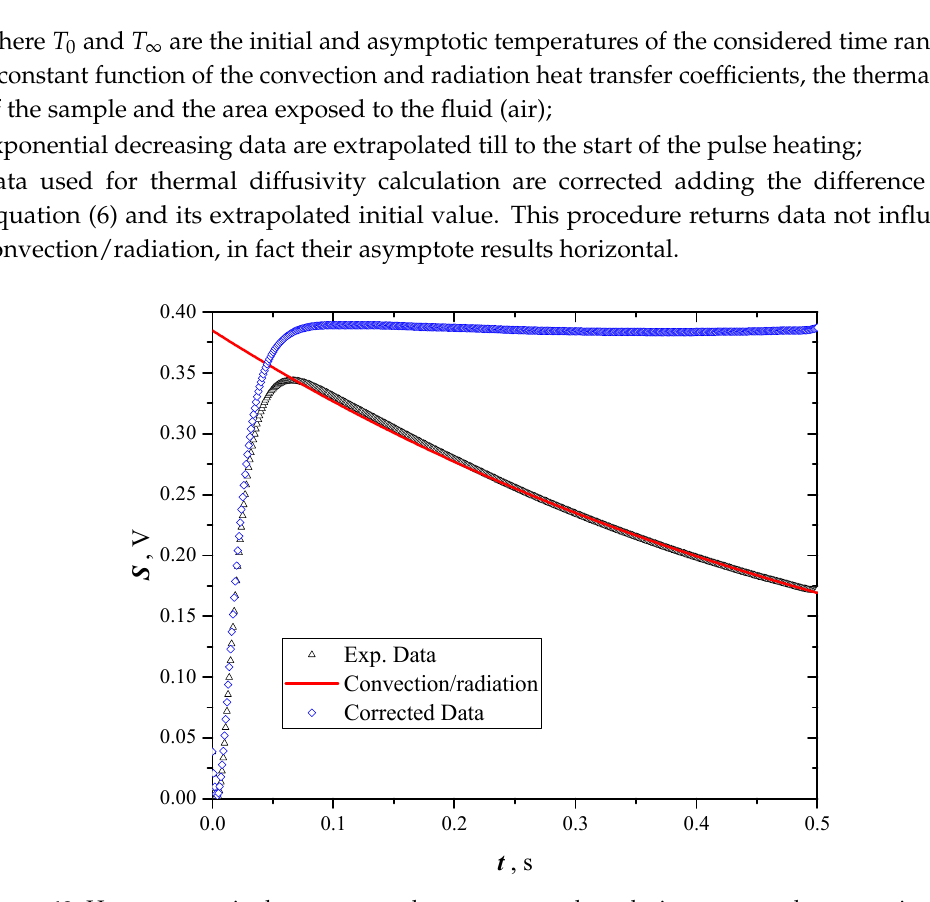
Figure 13. How raw acquired temperature data are corrected to take into account the convection heat transfer; red line: Pure convection trend evaluated with the lumped parameter model.